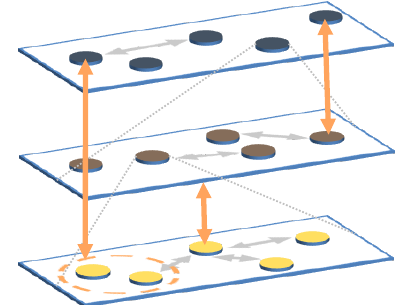
Figure 7: Multi-scale model with cross-scale interactions. Entities at same (grey) but also between different levels (orange) can exchange information and